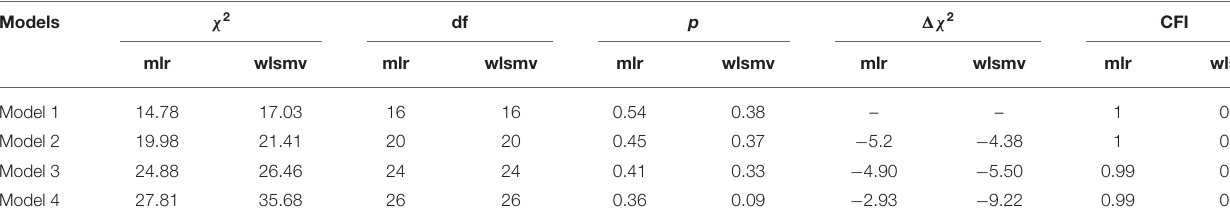
TABLE 6 | Scaled chi-square difference test of MPS p (method = “satorra.bentler.2001”). Models